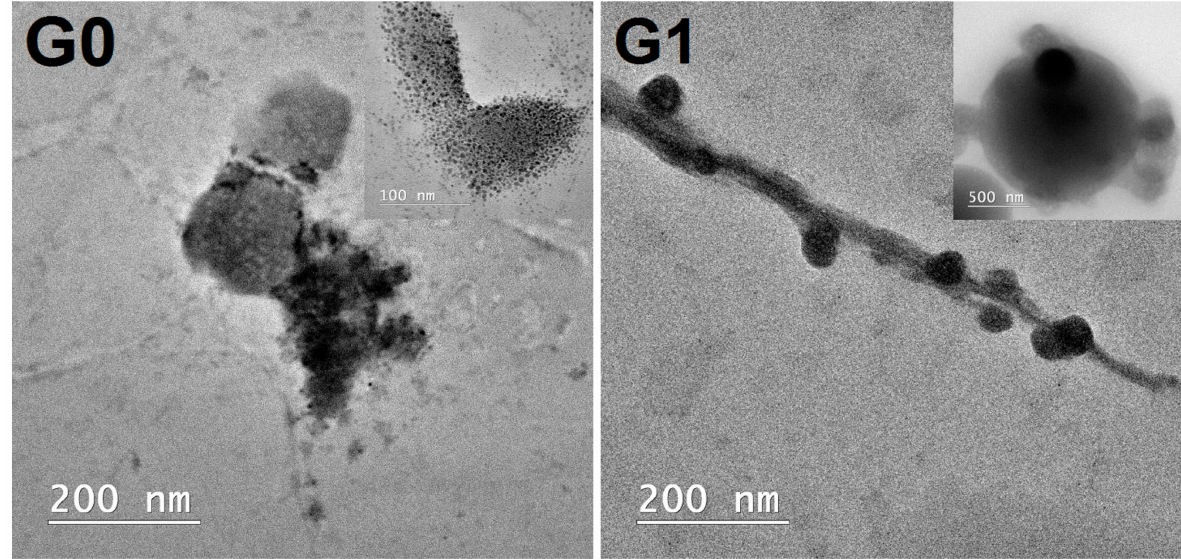
Figure 3. TEM images of SiO 2 NPs (sample G0) and silica-gentamicin nanostructured solution (sample G1), obtained as